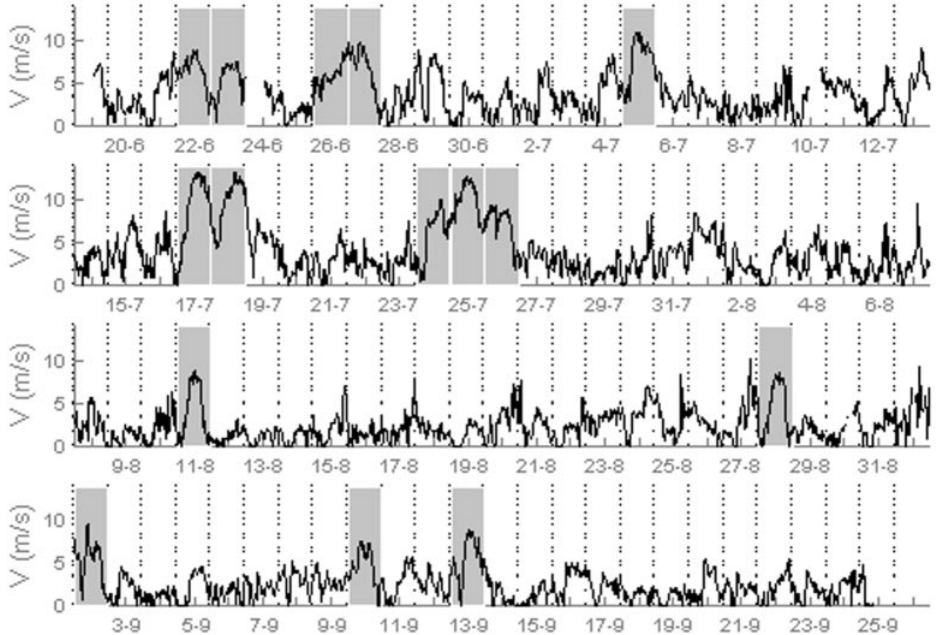
Fig. 8. Time series of wind speed for the whole 1997 WELSONS experiment. Data were averaged every 30 min, and Cierzo days are shown in grey